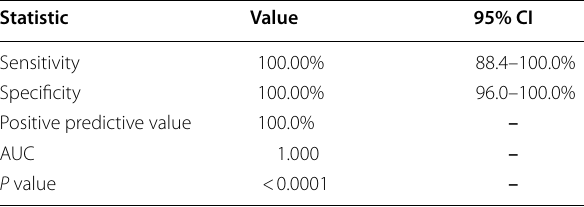
AUC, area under the curve